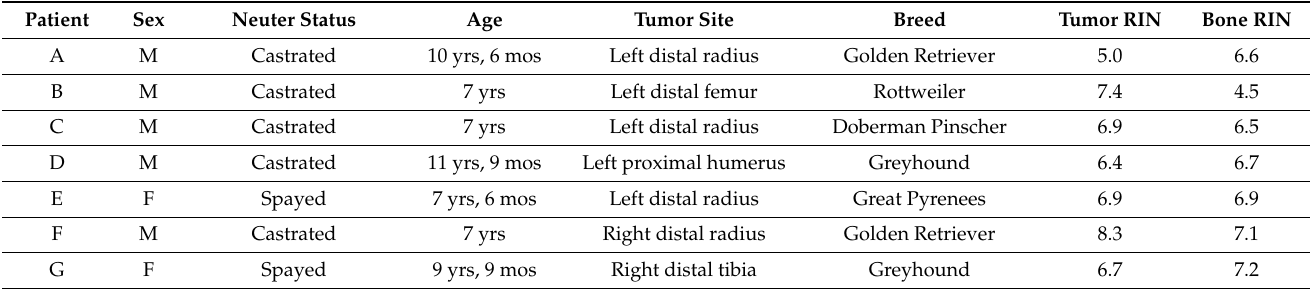
Table 1. Summary of canine osteosarcoma patients. Tumor and patient-matched normal bone samples were obtained from seven dogs undergoing limb amputation for osteosarcoma. Age is based on the date of limb amputation and breed is reported per the owner. (RIN = RNA integrity number, yrs = years, mos =